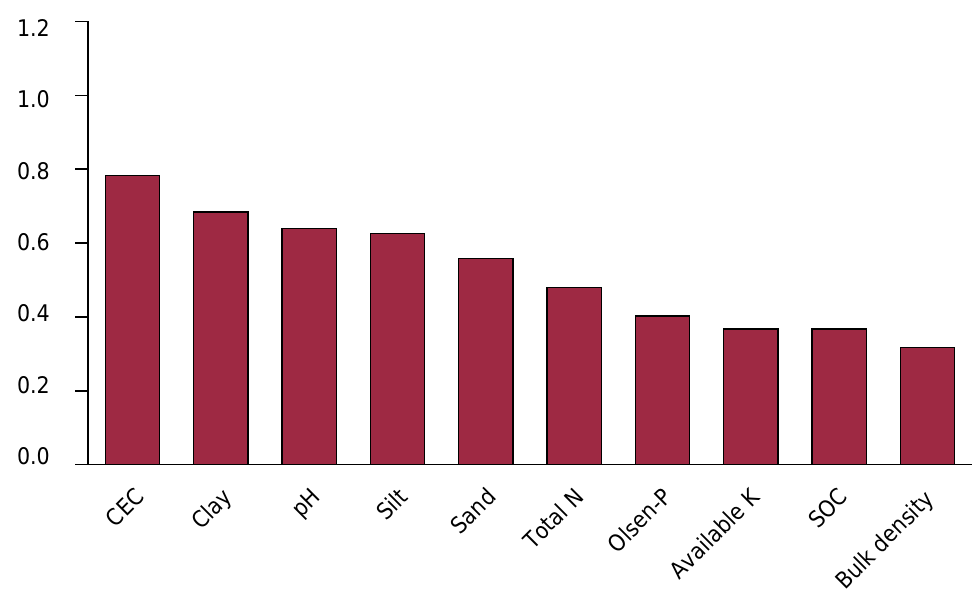
Figure 4. Variable importance in the principal component